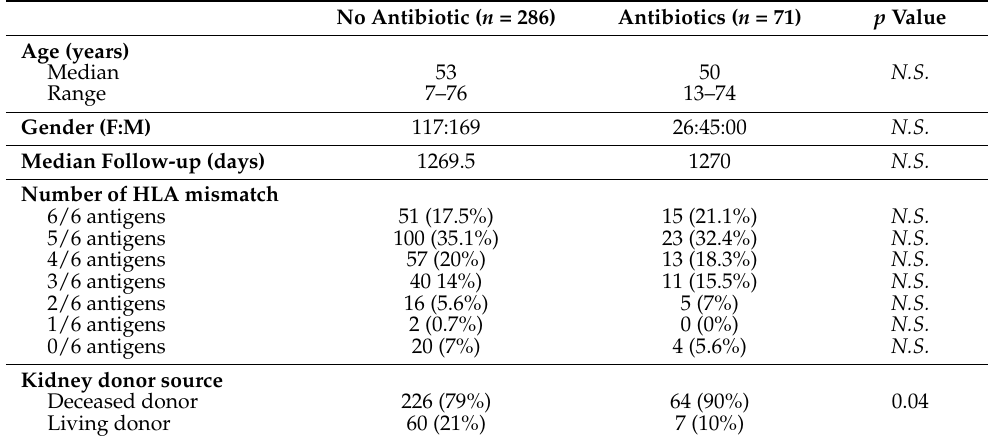
Table 1. Characteristics of patients.